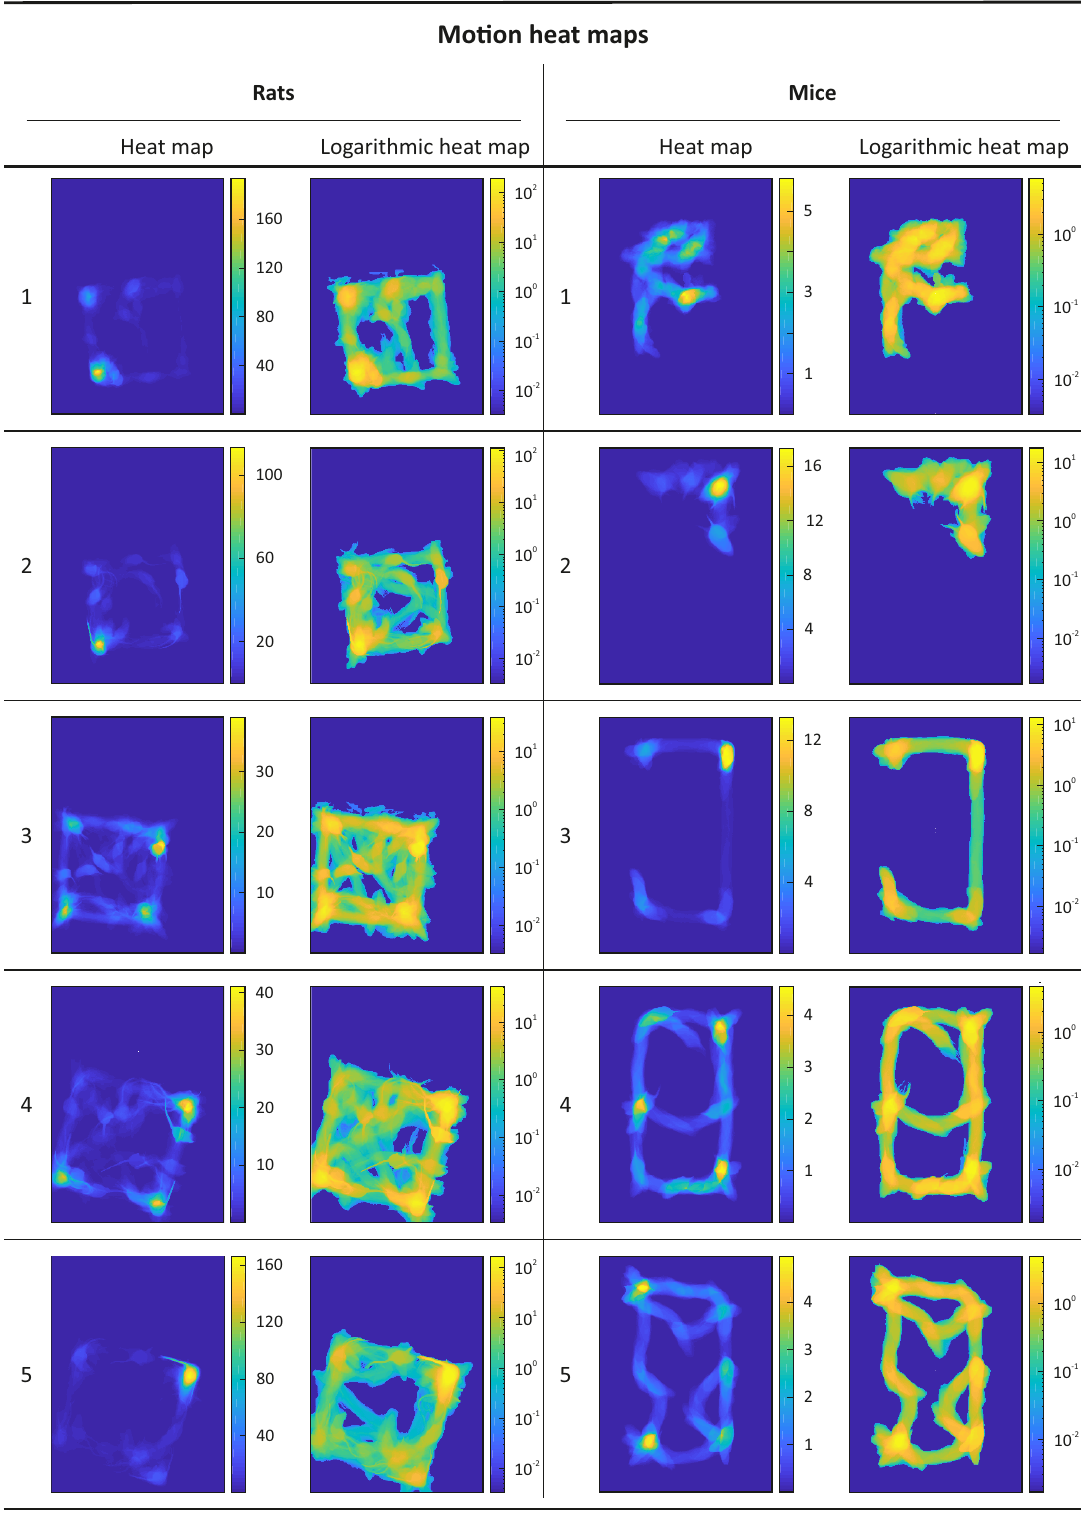
Figure 6. Motion heat maps and logarithmic motion heat maps representing the cumulative time that the rodents spent in the different parts of the arena. Yellow denotes more time and blue less or no time. The time periods are given in